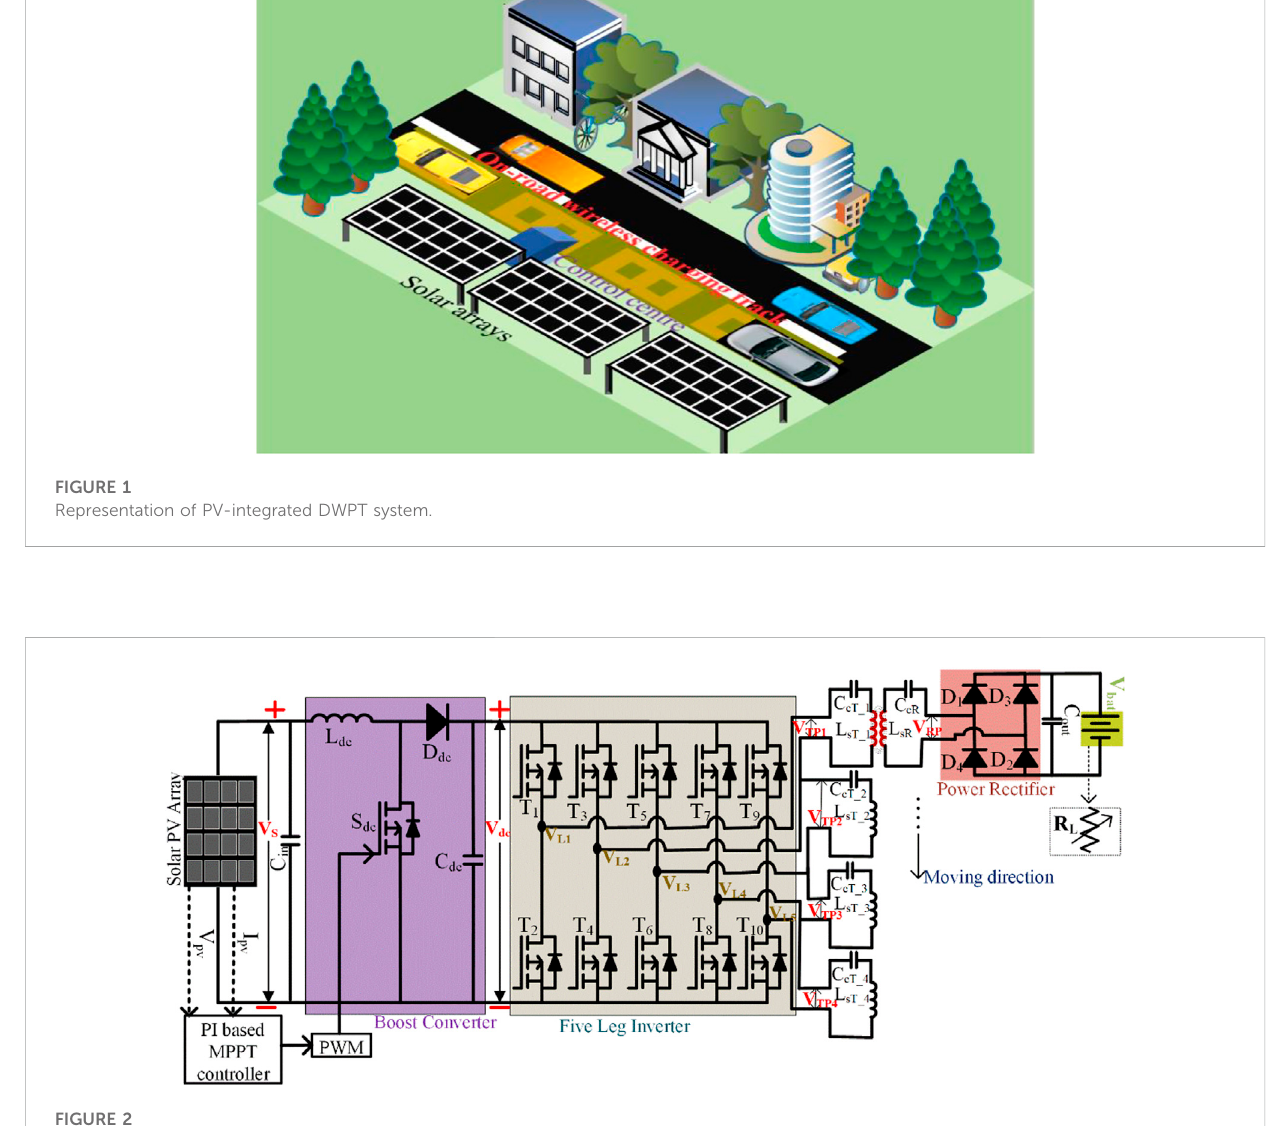
FIGURE 2 Circuit description of the proposed DWPT